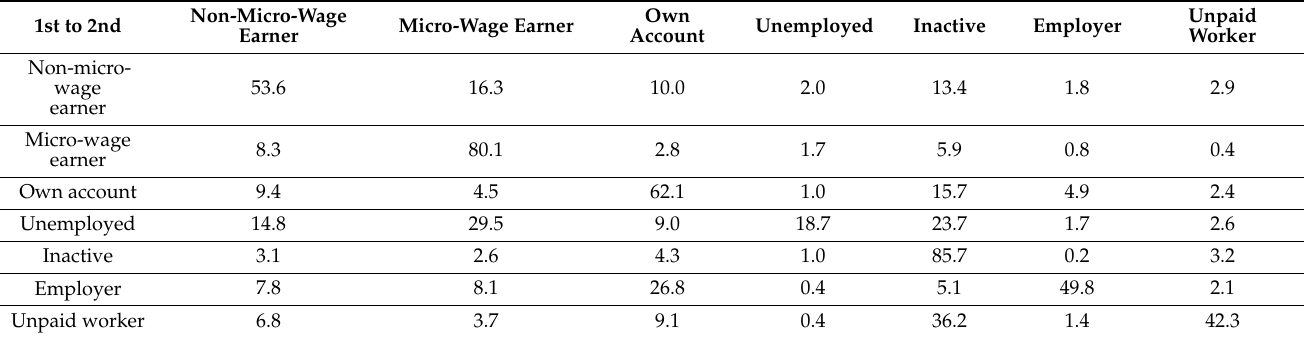
Table 1. Total activity flows of first quarter of 2006 (stability).